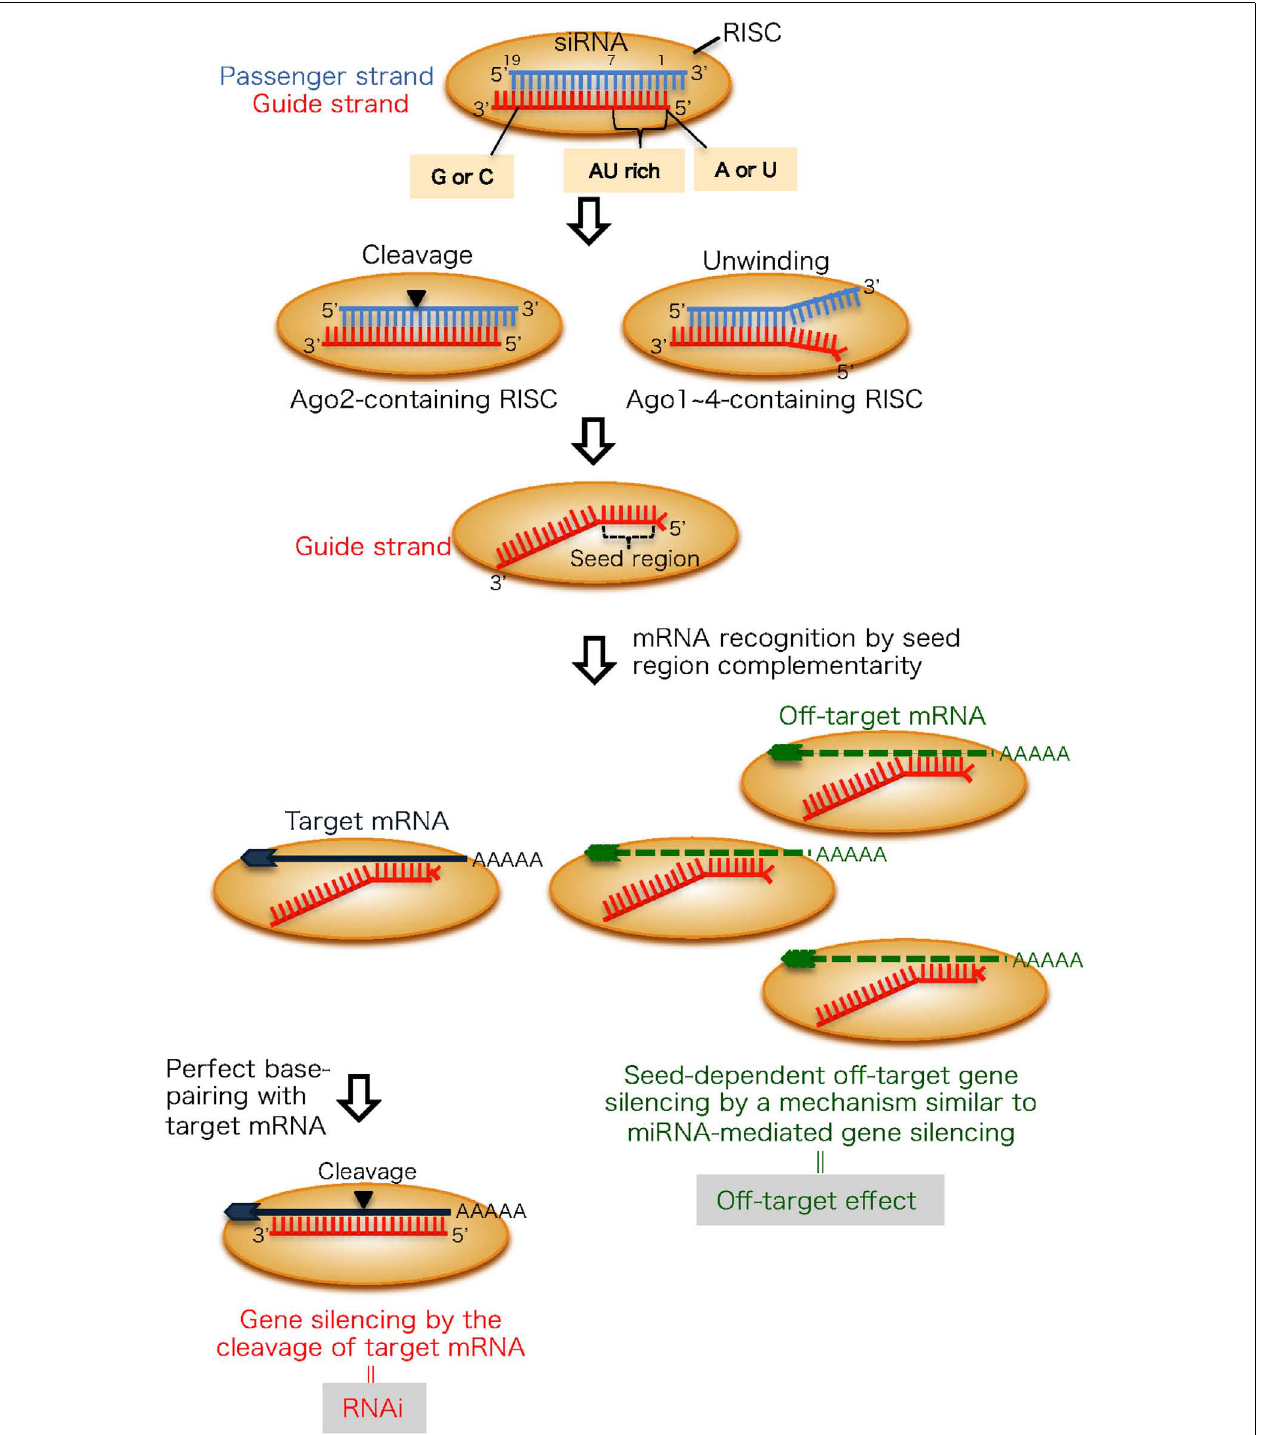
recognizes target and off-target transcripts with complementary sequences to seed region positions 2–8.The target transcript, which has complete complementarity in positions 9-21, in addition to positions 2–8, is knocked down by RNAi. Conversely, off-target transcripts are downregulated according to the thermodynamic stability in the duplex formed between the siRNA seed region and target mRNA.